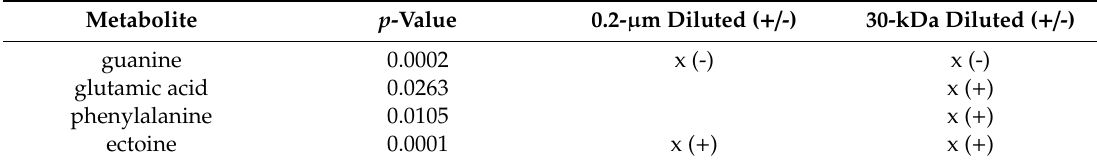
Table 2. Organic compounds that showed statistically significant di ff erences from the control at the final time point of the incubation. The p -values are from the one-way ANOVA; the rows marked with an ‘x’ indicate metabolites with di ff erences between each treatment and the control using the Dunnett’s post hoc multiple comparisons test. The sign ( + or -) indicates increase or decrease, respectively. Metabolite p -Value 0.2- µ m Diluted ( +/ -) 30-kDa Diluted ( +/